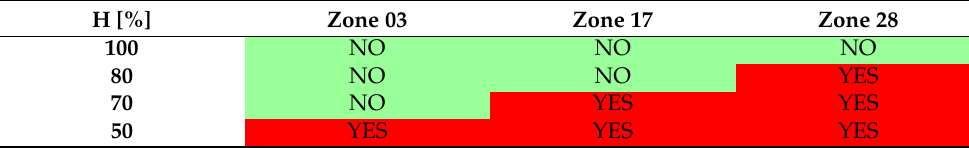
Table 3. Hardware-in-the-loop relay trip results, 1000 MW infeed loss at Zone 03. Yes (red) = tripped; No (green) = not